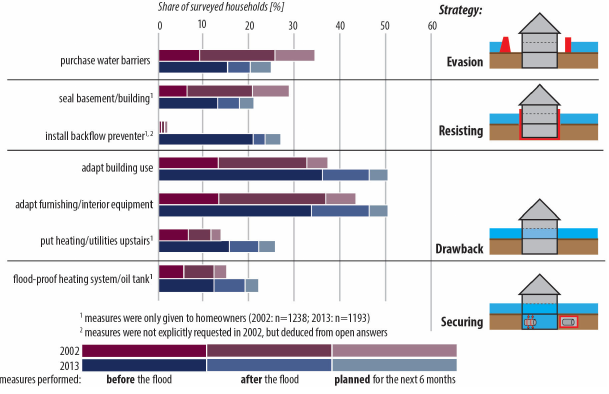
Fig. 3 . Property-level mitigation measures performed by flood- affected residents before and after the flood in 2002 or 2013 and measures planned for the next six months. Note that some measures (marked in the figure with 1) can only be implemented by homeowners; hence tenants were not asked about their